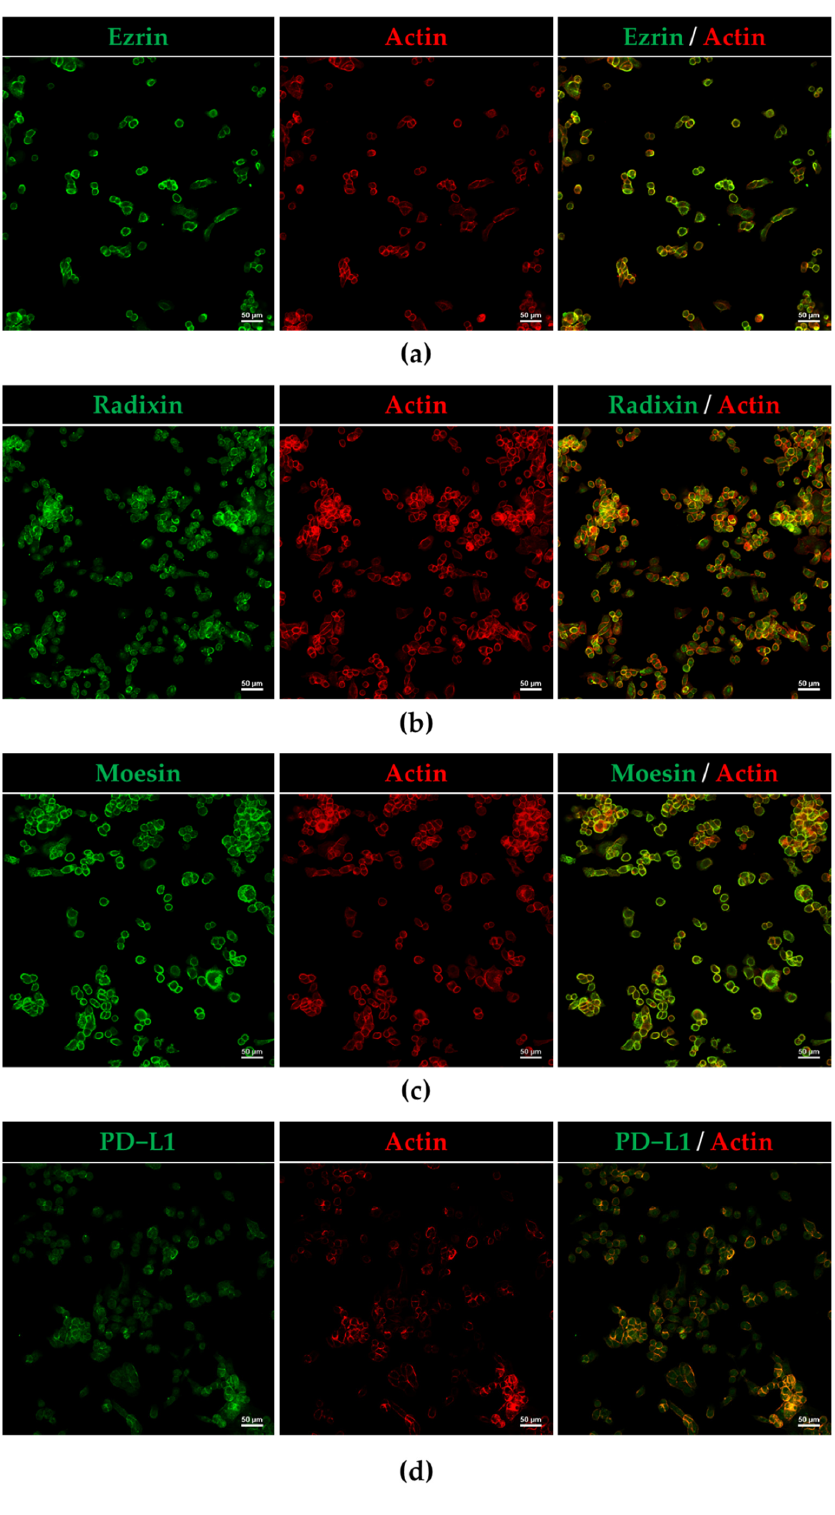
Figure 2. Plasma membrane localization of ezrin, radixin, moesin (ERM), and programmed death ligand-1 (PD-L1) in HEC-151 cells. Three-dimensional reconstructions of optically sectioned HEC- 151 cells as analyzed by confocal laser scanning microscopy showed the intracellular localization of ( a ) ezrin, ( b ) radixin, ( c ) moesin, and ( d ) PD-L1 (Alexa Fluor 488) counterstained with actin (tetramethylrhodamine; TRITC), a typical plasma membrane marker. Scale bars: 50 µ